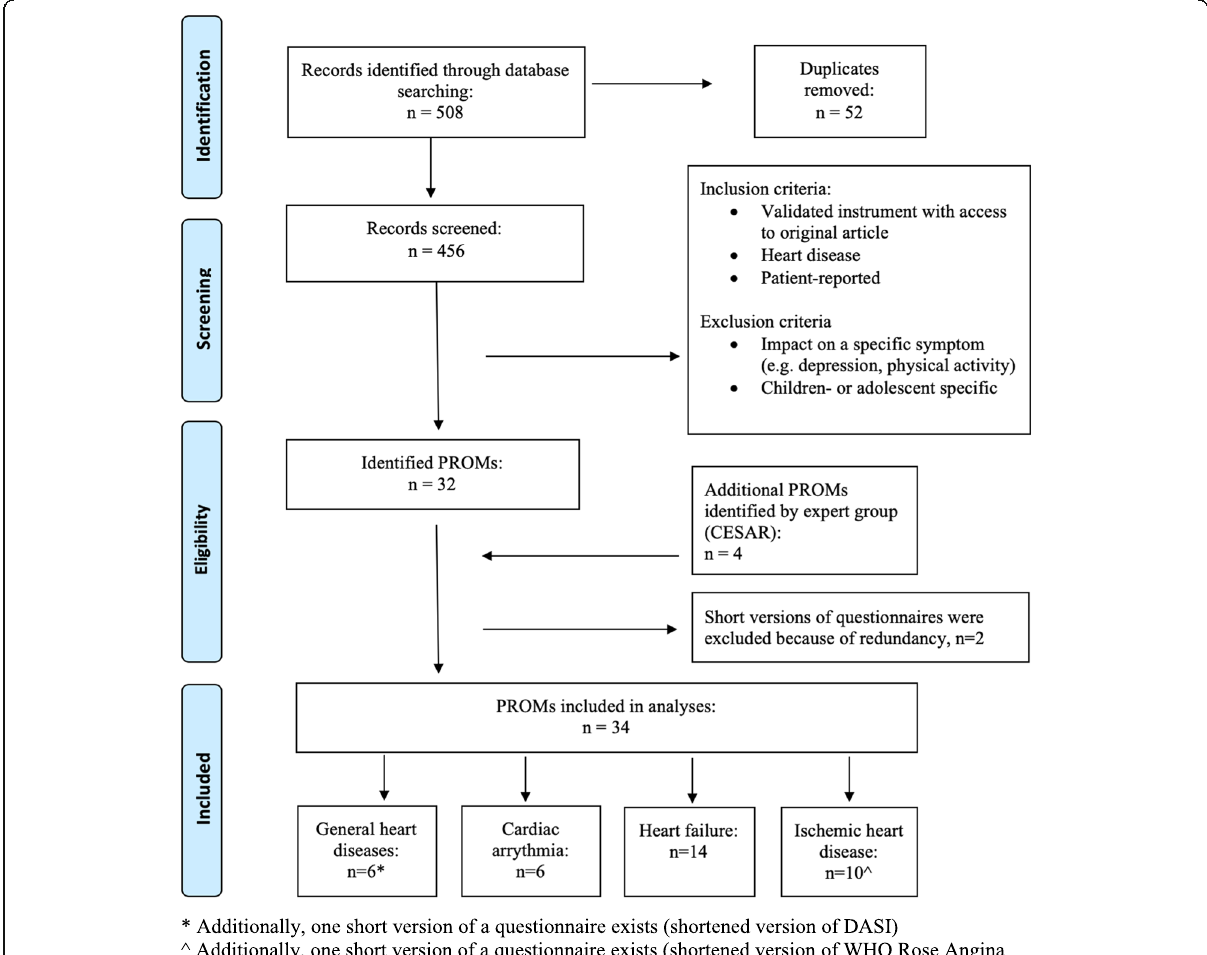
Fig. 1 Flow diagram of the literature search in PubMed, conducted in January